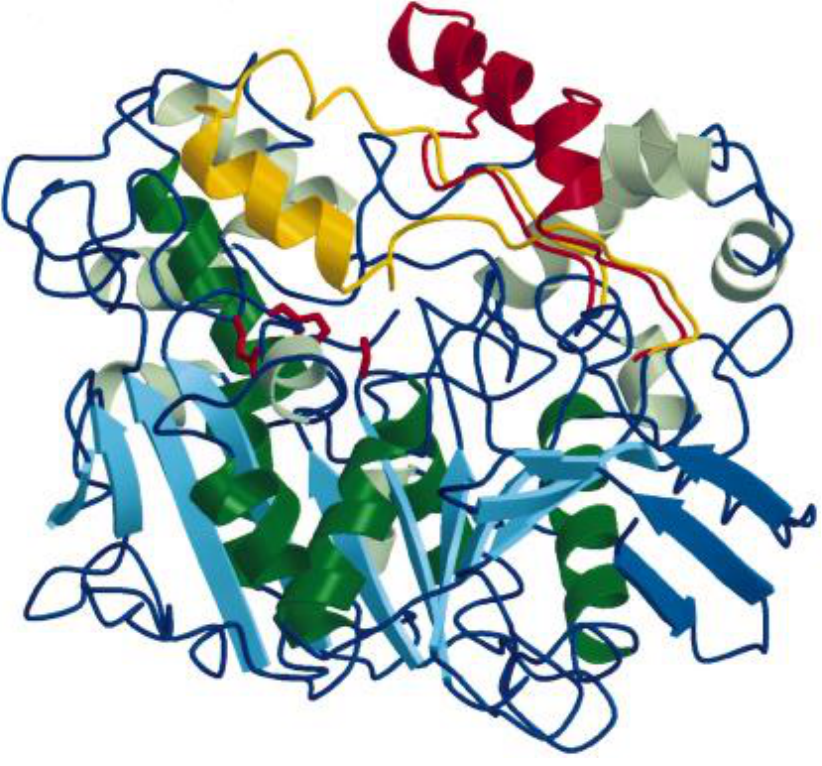
Figure 1. Ribbon diagram of CRL with open and closed states of the lid superimposed. The central mixed β-sheet is light blue, and the smaller N-terminal β-sheet is dark blue. Helices that pack against the central β-sheet are dark green. The closed conformation of the lid is yellow, and the open conformation is red. The residues forming the catalytic triad are shown in red [1]. Reprinted